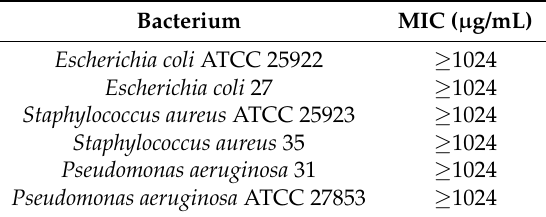
Table 2. The hexanic Zea mays silk extract (HEZM) minimum inhibitory concentration (MIC) against standard and resistant bacterial